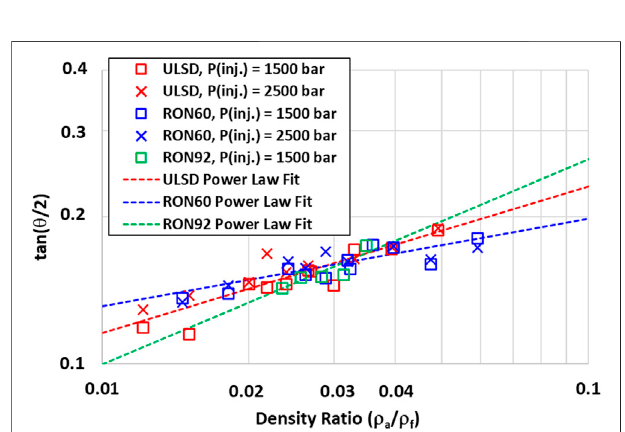
FIGURE 20 | Tangent of vaporizing dispersion half-angle vs. density